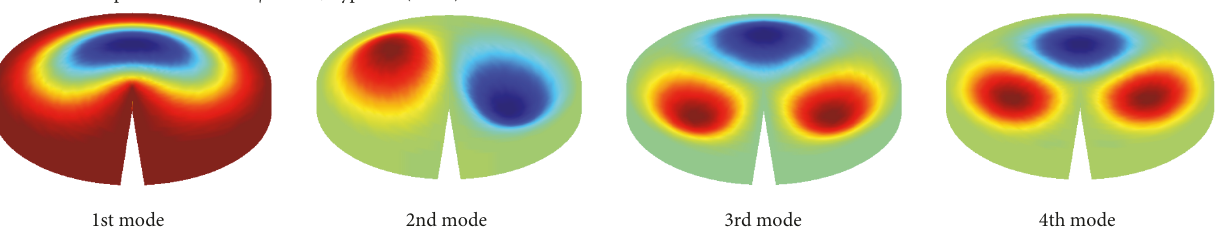
Figure 7: Mode shapes of the FG sandwich circular sector plate with E 2 SE 2 boundary condition and different sector